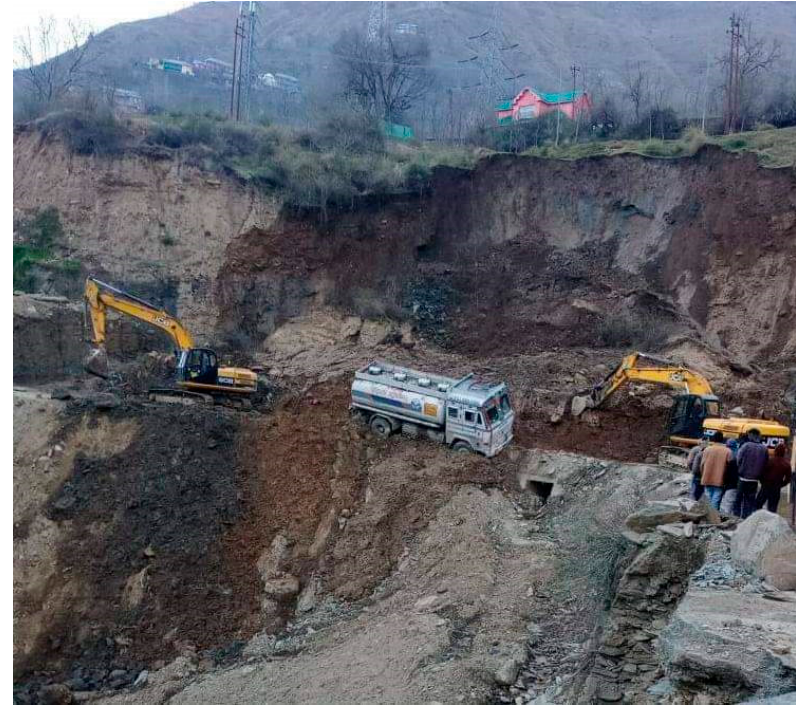
Figure 2. Prominent landslide site at Ramban along the NH 44. 160180200 120140 Figure 3. Daily mean precipitation of the study area from 2000 to 2020 based on the Tropical Rainfall Monitoring Mission (TRMM) data. 3. Materials and Methods 3.1. Field Observation and Data Field observation is an effective procedure for landslide hazard assessment to collect the primary field data (distance to road, distance to river, and general evaluation of the location) for the study [39]. The mapping and landslide susceptibility analysis of land- slide-prone areas is the first stage in the field observation [40]. As part of the research, a 0 20406080 100